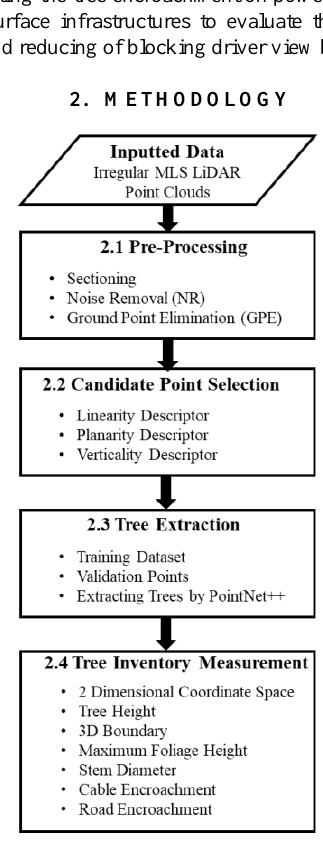
Figure1. Flowchart of the proposed